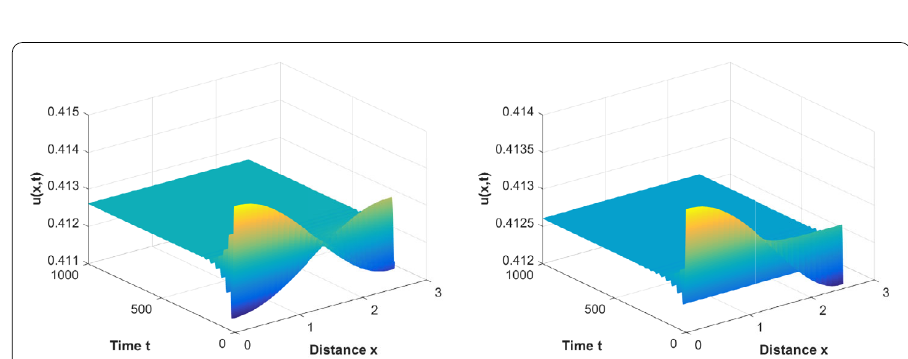
Figure 4 Numerical simulations for prey population with β = 0.5 τ = 5. (Left: model (1.4). Right: model (2.9))